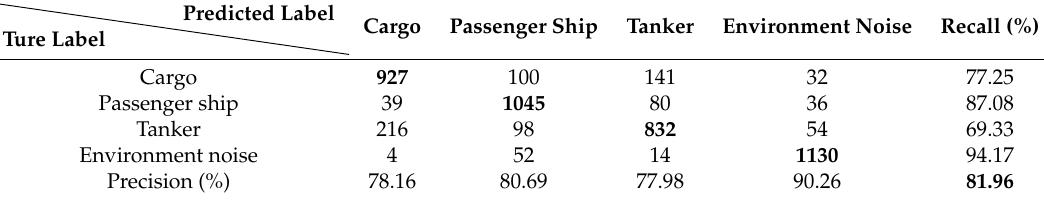
Table 4. Confusion matrix of the proposed model obtained from testing data. The bold numbers in diagonal indicate the number of correctly classified samples; the bottom right bold number indicates the overall